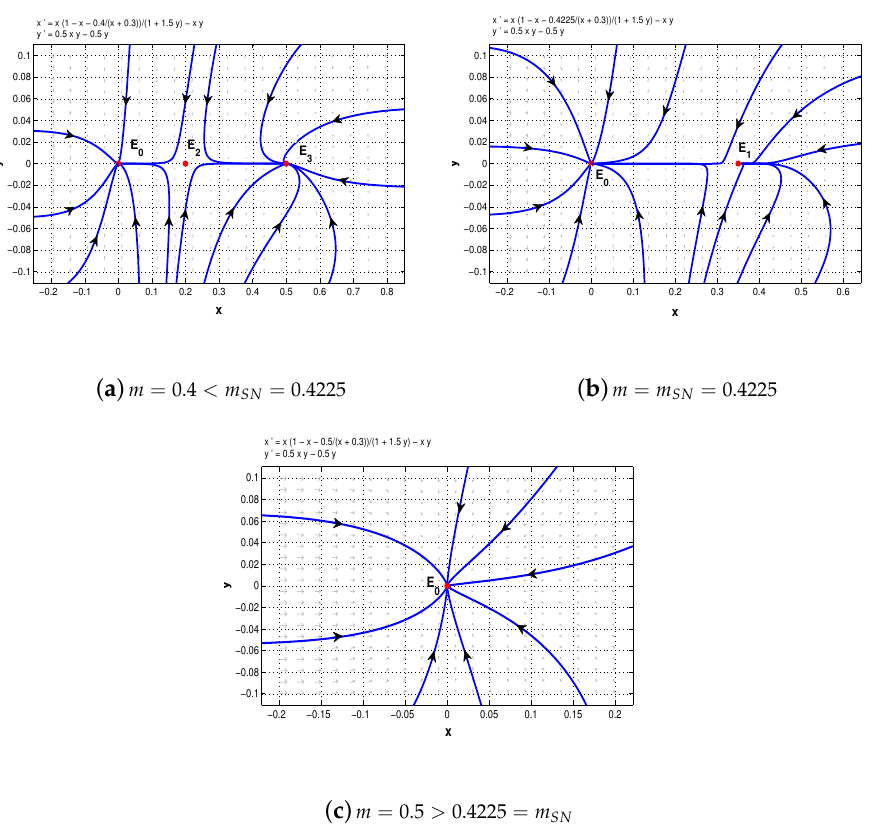
Figure 1. ( a ) Two distinct boundary equilibria and one trivial equilibrium when m < m SN : there are two stable nodes E 0 and E 3 , and a saddle E 2 . ( b ) A boundary equilibrium and a trivial equilibrium when m = m SN : E 3 is a saddle-node and E 0 is a stable node. ( c ) A trivial equilibrium when m > m SN : E 0 is a stable